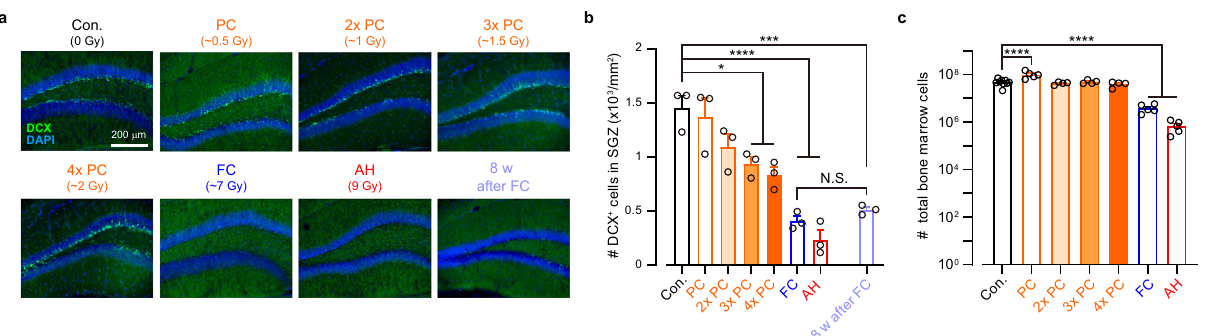
Fig. 6 X-ray dose-dependent effects on immature neurons and bone marrow cells. a Representative epi- fl uorescence images of doublecortin (DCX) immunoreactivity (green) at the hippocampal dentate gyrus two days after acute high-dose radiation (AH), “ Pulsed conditioning ” (PC), double (2×) PC, triple (3×) PC, quadruple (4×) PC, “ Free moving conditioning ” (FC), or no radiation (Con), or at 8 weeks after FC radiation (8 w after FC). Blue: DAPI. b Quanti fi cation of DCX-positive cells under different conditions ( n = 3 mice for each group). Con vs. PC, p > 0.9999; Con vs. 2× PC, p = 0.531; Con vs. 3× PC, * p = 0.0488; Con vs. 4× PC, * p = 0.0102; Con vs. FC, **** p < 0.0001; Con vs. AH, **** p < 0.0001; Con vs. 8 w after FC, *** p = 0.0001; FC vs. 8 w after FC, p > 0.9999; Bonferroni ’ s multiple comparison test, two-sided. c Quanti fi cation of total bone marrow cells three days after X-irradiation (Con, n = 9 mice; PC, n = 5 mice; 2× PC; n = 4 mice; 3× PC, n = 4 mice; 4× PC, n = 4 mice; FC, n = 5 mice; AH, n = 5 mice). PC, **** p < 0.0001; 2× PC, p = 0.987; 3× PC, p = 0.9998; 4× PC, p = 0.887; FC, **** p < 0.0001; AH, **** p < 0.0001; Dunnett ’ s multiple com p arison tests vs. Con, two-sided. N.S.: not signi fi cant. Open circles indicate individual data. Values are mean ±